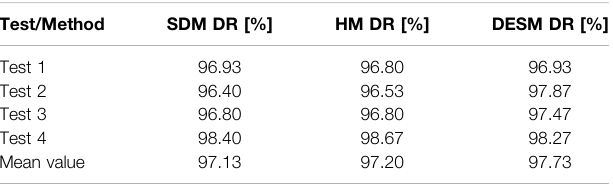
TABLE5| Testingphase.DRandmeanvaluesforSDM,HM,DESMachievedwith Test 1, 2, 3, 4 performed in Environment 1 with detection thresholds of Environment 2.